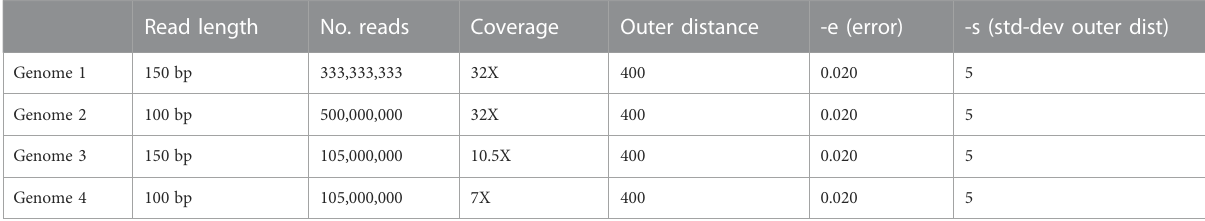
TABLE 1 Custom parameters used to generate the simulated data. All parameters not included in this table were kept as default. Read